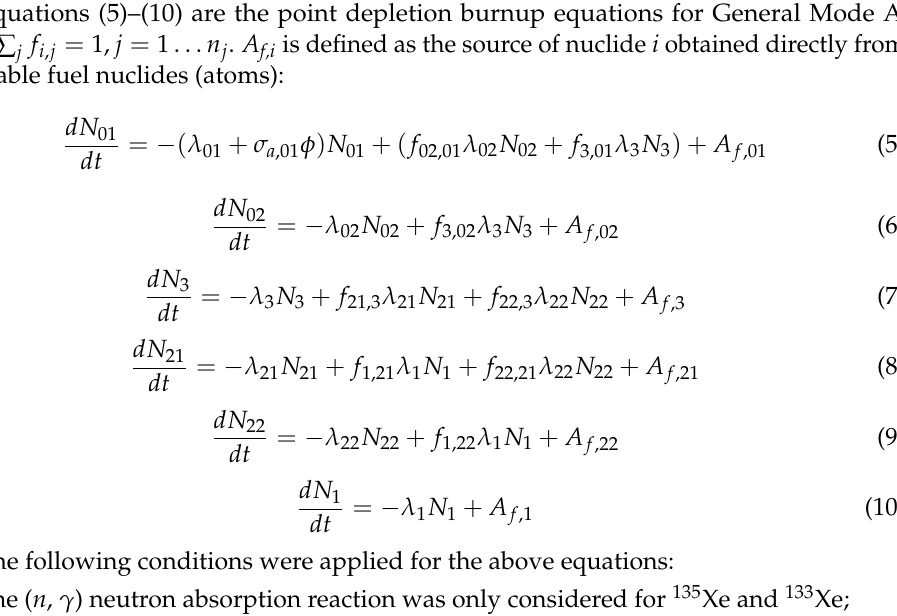
Figure 3. General Mode A for the decay chain. Further, General Mode A was derived from the decay chain for 133 Xe and 133m Xe in Figure 3b, in which the 100% decay fraction was omitted for simplification. In Figure 3, Ai refers to the activity of nuclide i, where i can be equal to 1, 21, 22, 3, 01, or 02; and f i,j refers to the decay fraction from nuclide i to nuclide